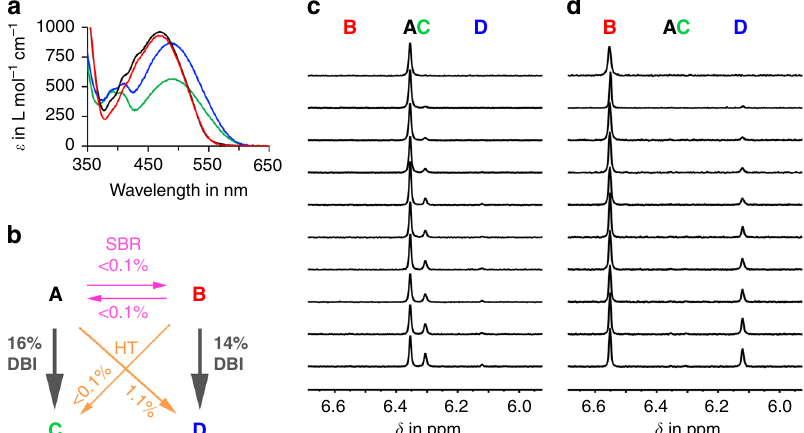
Fig. 2 Photoreactions of HTI 1 during 520nm irradiation. a Molar absorption coef fi cients in cyclohexane solution. b Experimental quantum yields determined for the photoreactions of isomers A and B in cyclohexane- d 12 solution at 27 °C under 520 nm irradiation. c Beginning of the photoreaction of isomer A in cyclohexane- d 12 at 27 °C. d Beginning of the photoreaction of isomer B in cyclohexane- d 12 at 27